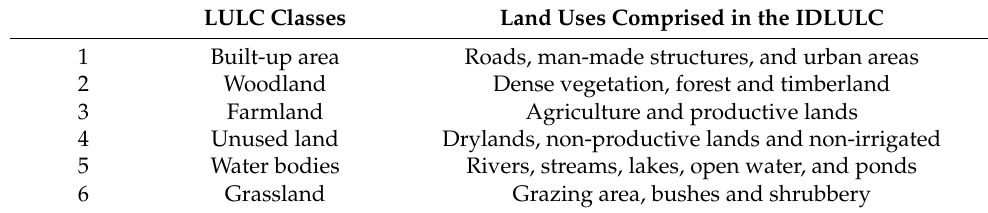
Table 2. Description of land use/land cover (LULC)